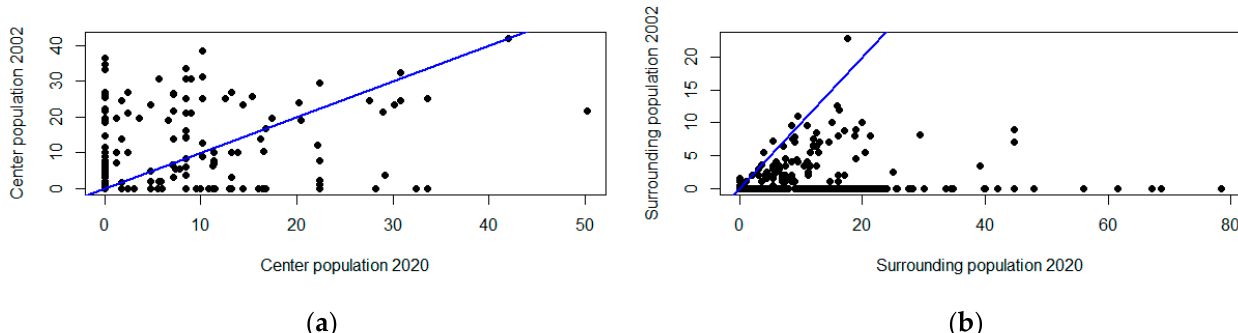
Figure 11. ( a ) One-to-one plot of values that shows population density differences in the center between 2002 and 2020. Circles below or to the right of the blue one-to-one line indicate observations with a higher value for population density in 2020 than for population density in 2002. ( b ) One-to-one plot of values that shows population density differences in the surrounding locations between 2002 and 2020. Circles below or to the right of the blue one-to-one line indicate observations with a higher value for population density in 2020 than for population density in 2002. Population density is in 10 3 .